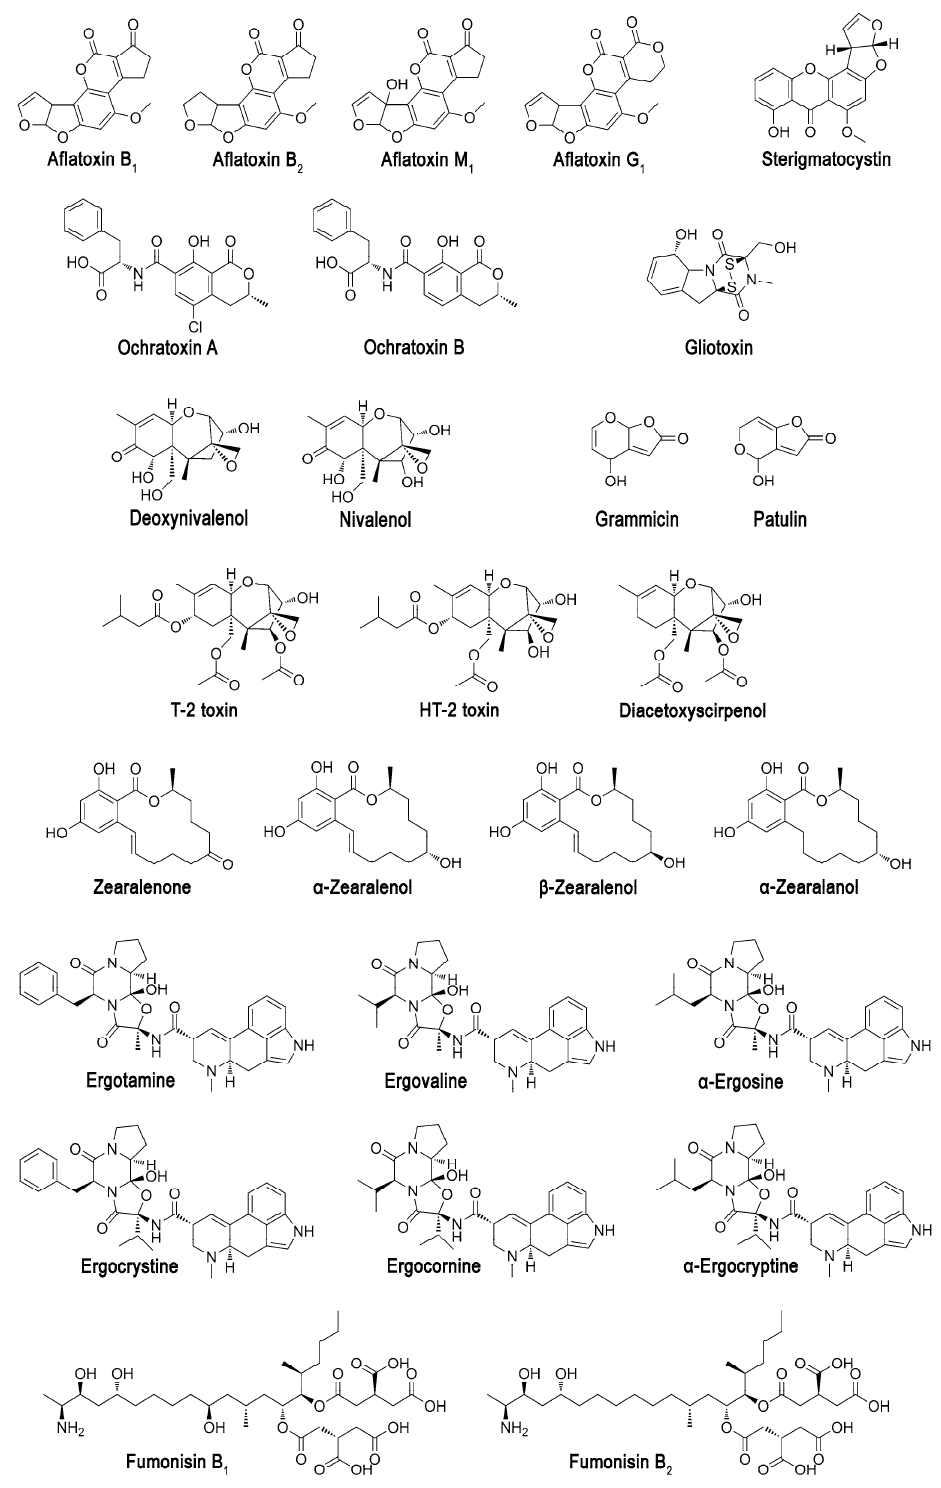
Figure 1. Chemical structures of some mycotoxins.